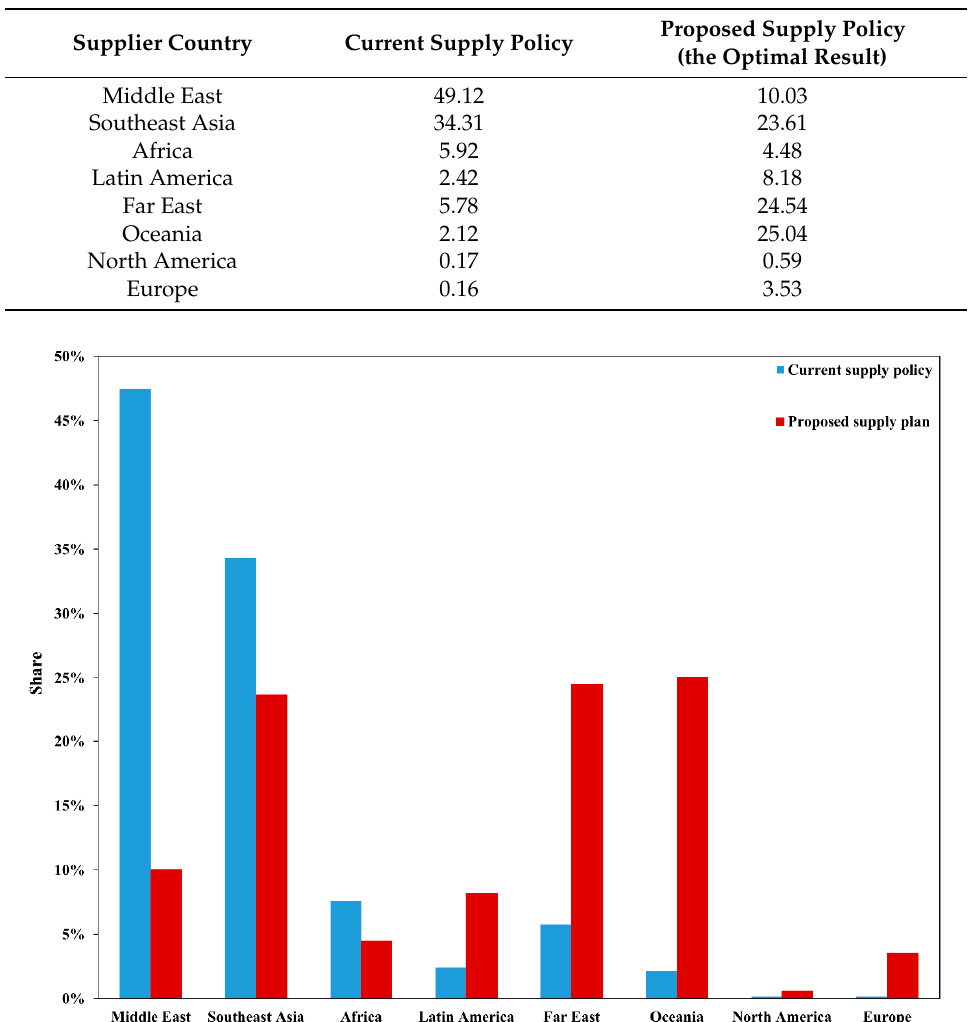
Table 10. Comparison of portfolio analysis results for each continental region (%).